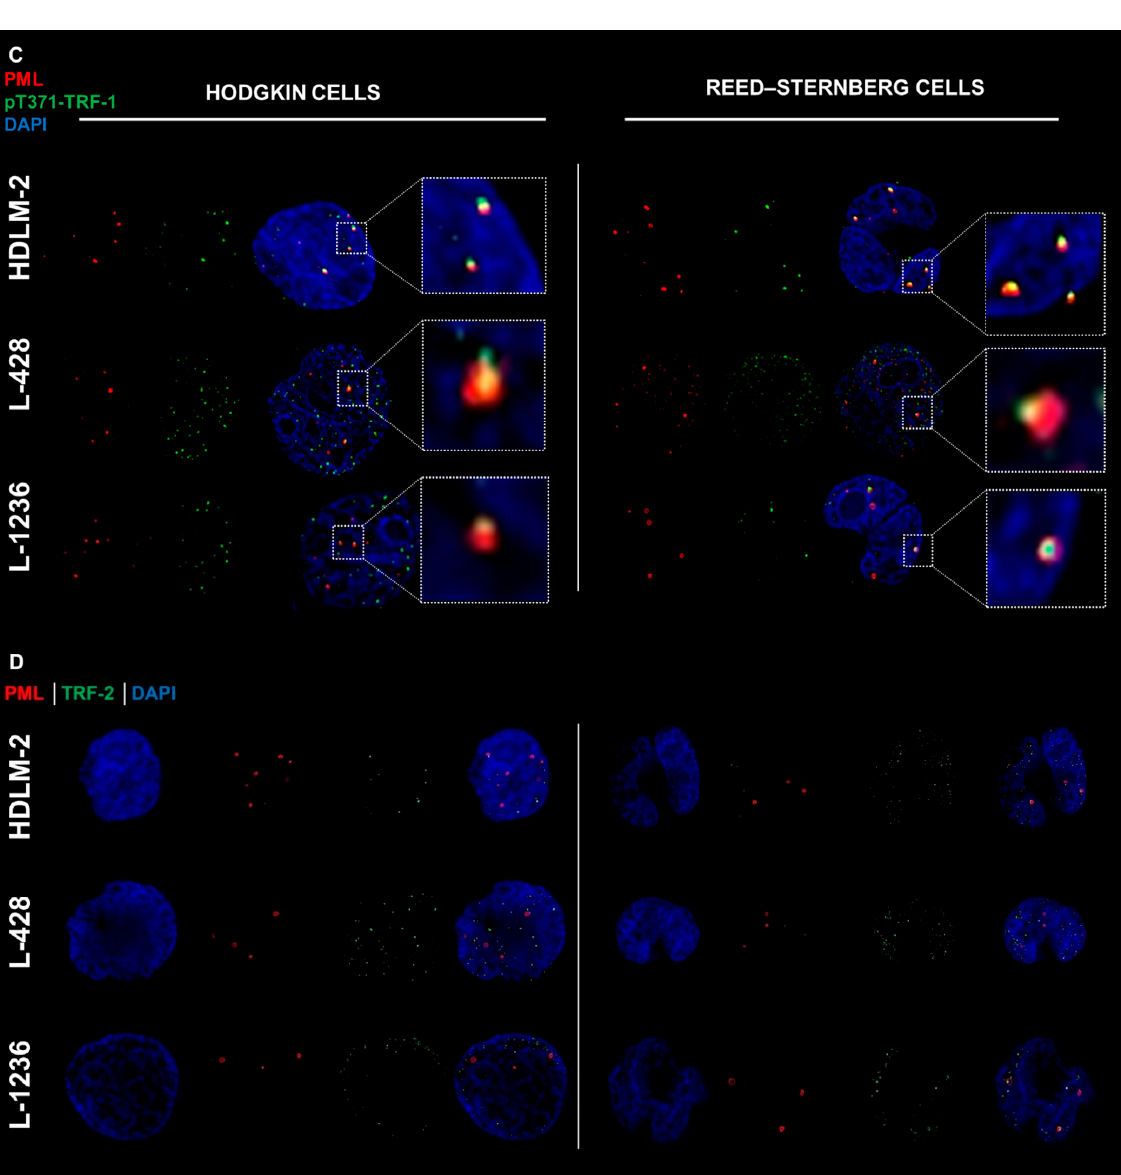
Figure 2. Hodgkin’s Lymphoma (HL) shows hallmarks of an alternative telomere lengthening (ALT) pathway. ( A ) HL cell lines show promyelocytic leukemia bodies (PML) in both HL cell phenotypes (Hodgkin cells and Reed–Sternberg cells). ( B ) HL cell lines show phosphorylated form of telomeric repeat-binding factor 1 (pT371-TRF1) in both HL cell phenotypes. ( C ) HL cell lines show colocalization (white zoom boxes) of pT371-TRF1 and PML bodies in both HL cell phenotypes. ( D ) HL cell lines show presence of telomeric repeat-binding factor 2 (TRF2) around PML bodies in both HL cell phenotypes. PML—Red (Cy3), pT371-TRF1—Green (A-488), TRF2—Green (A-488) and DNA—Blue (DAPI). A total of 90 cells were examined in three independent experiments for each of the HL cell lines, and all showed both colocalized (yellow) as well as free signals for pT371-TRF1 and PML in addition to TRF2 and PML in both H and RS cells. For additional information, see Appendix A Figure A2. The telomeric repeat-binding factor 2 (TRF2) protein is associated with ALT telomere synthesis and works to maintain ALT pathway activity [46,47]. TRF2 protein is seen in all HL cell lines and, in both H and RS cells (Figure 2D). APBs are present in all HL cells. Analysis of colocalization to pT371-TRF1 and PML as well as of TRF2 and PML in 90 cells and three independent experiments showed for each of the HL cell lines